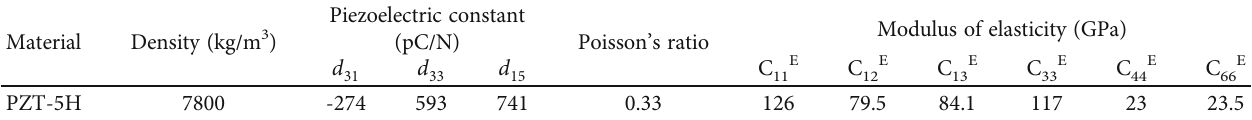
Table 2: The electrical and mechanical properties of the piezoelectric material.